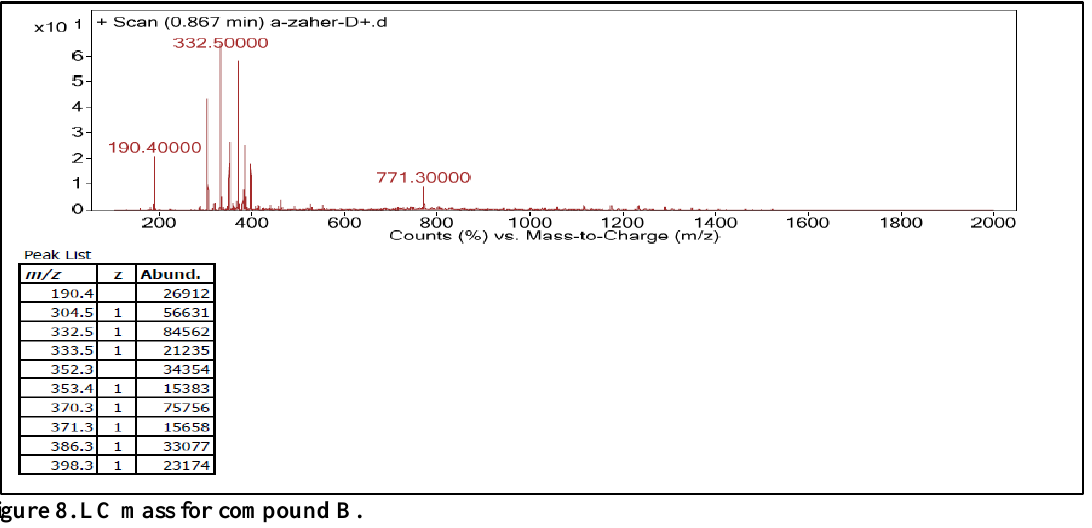
Figure 8. LC mass for compound B.